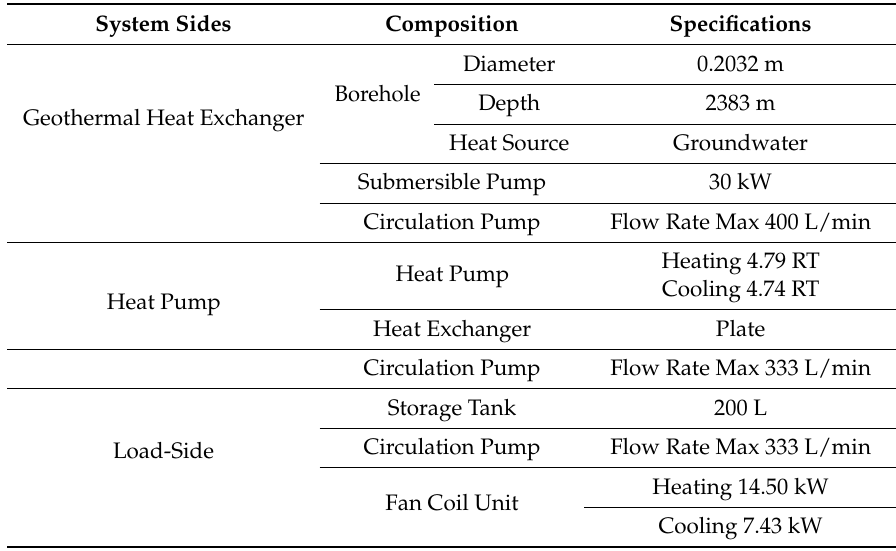
Table 1. System configuration.